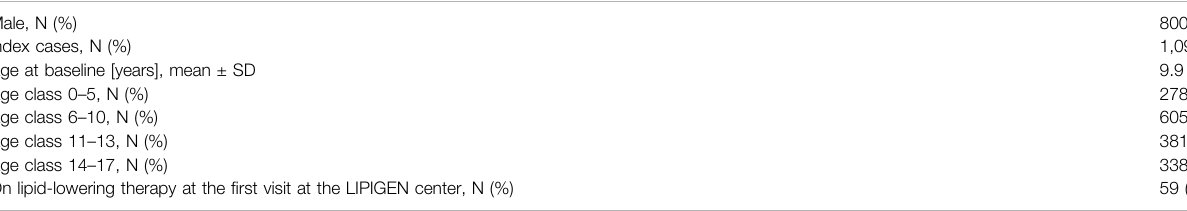
TABLE 2 | Lipid pro fi le among untreated and treated subjects at the moment of the fi rst visit at the LIPIGEN center. LDL cholesterol [mg/dL], mean ± SD